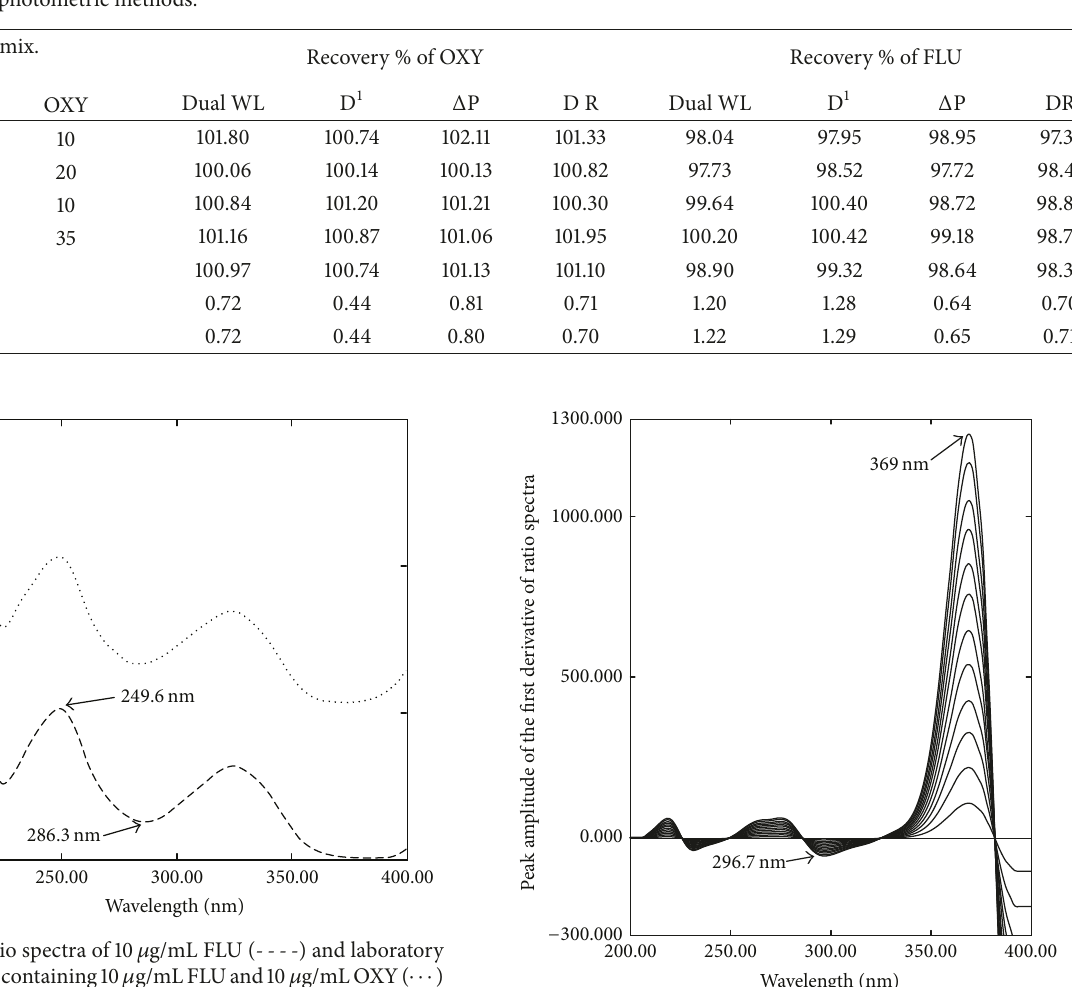
Table 2: Result obtained for the determination of Oxytetracycline HCl and Flunixin Meglumine in laboratory prepared mixtures by the proposed spectrophotometric methods.